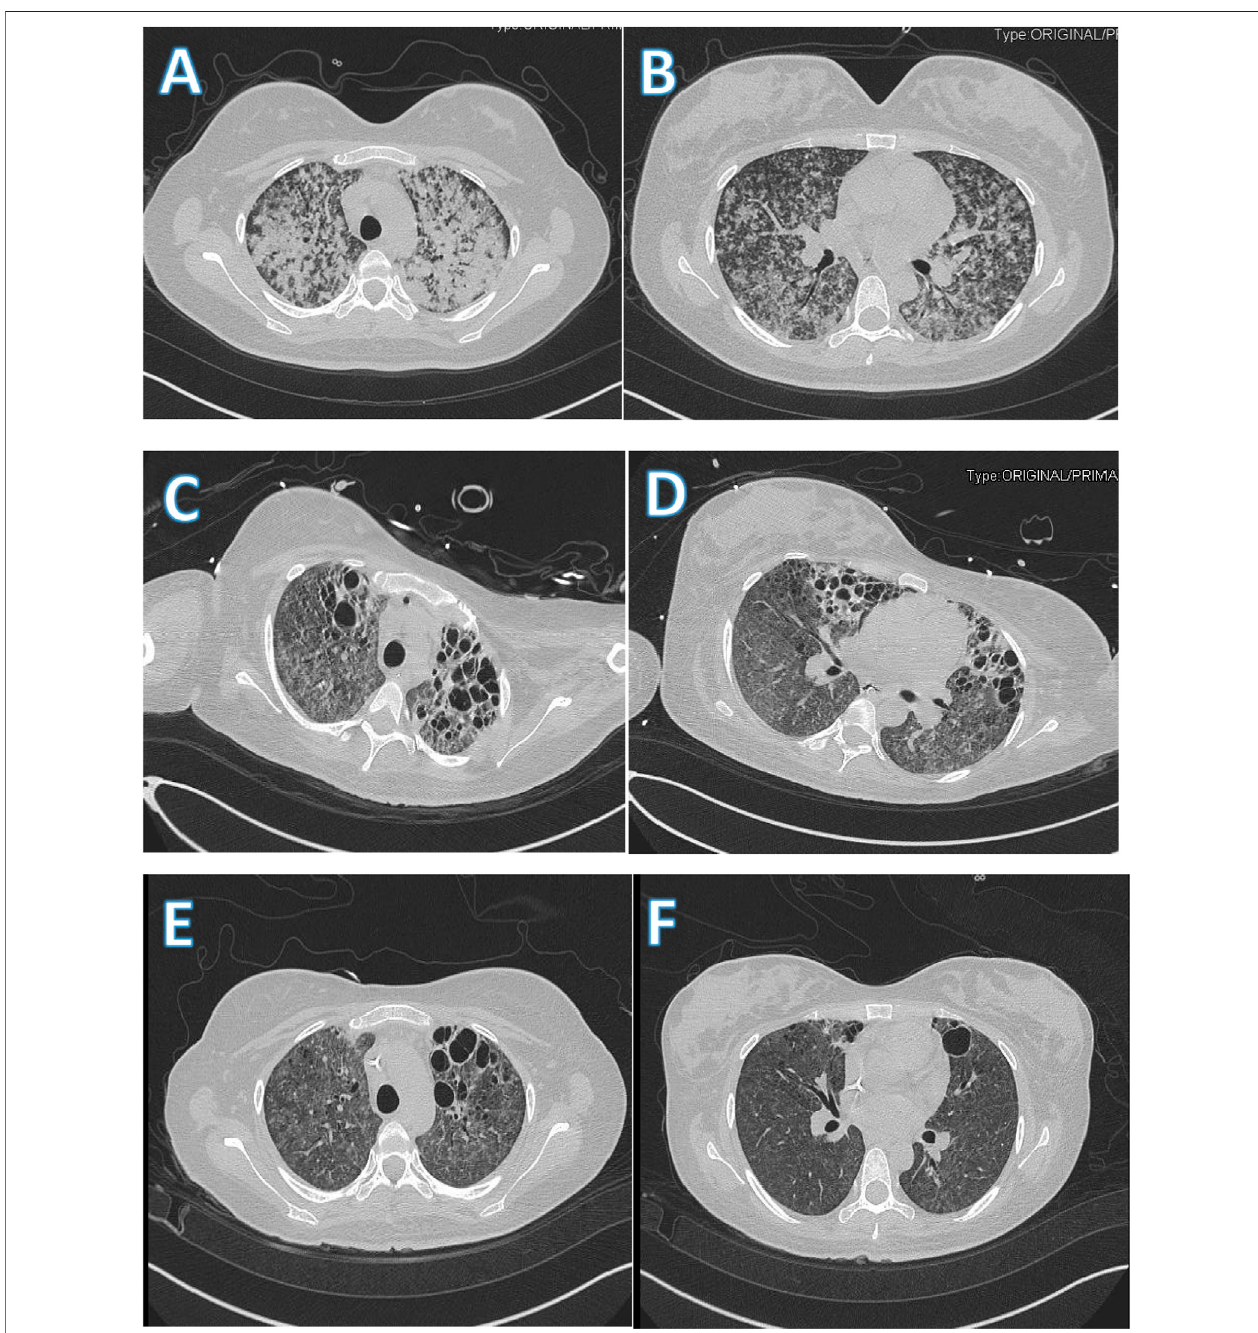
FIGURE1| ImageofchestCTscan. (A,B) chestCTonadmissionshowedmultiplemiliarynodularlesionsthatwerepartiallyclusteredandconsolidateddiffuselyin both lungs; (C,D) After 36 days of treatment, chest CT showed absorption of miliary nodular lesions and new vesicles in the bilateral lung; (E,F) After 56 days of treatment, chest CT showed absorption of miliary nodular lesions and vesicles in the bilateral upper lung.